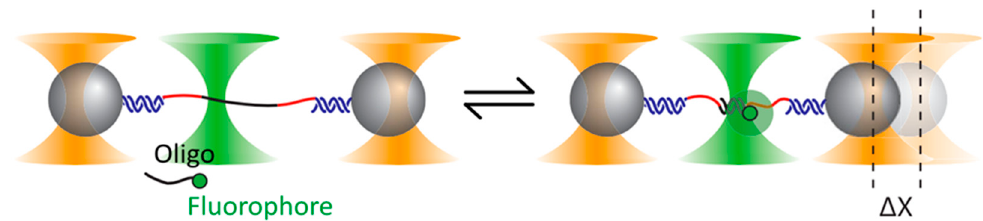
Figure 8. Experimental setup adopted by Whitley et al. [100]. The single-stranded DNA (ssDNA) binding site (black in the figure) is connected by means of two spacers (red) and two double-stranded DNA (dsDNA) handles (blue) to two trapped beads. Binding events of the tagged oligonucleotides are identified by confocal fluorescence. Reprinted with permission from [100]. Copyright 2018 American Physical Society.